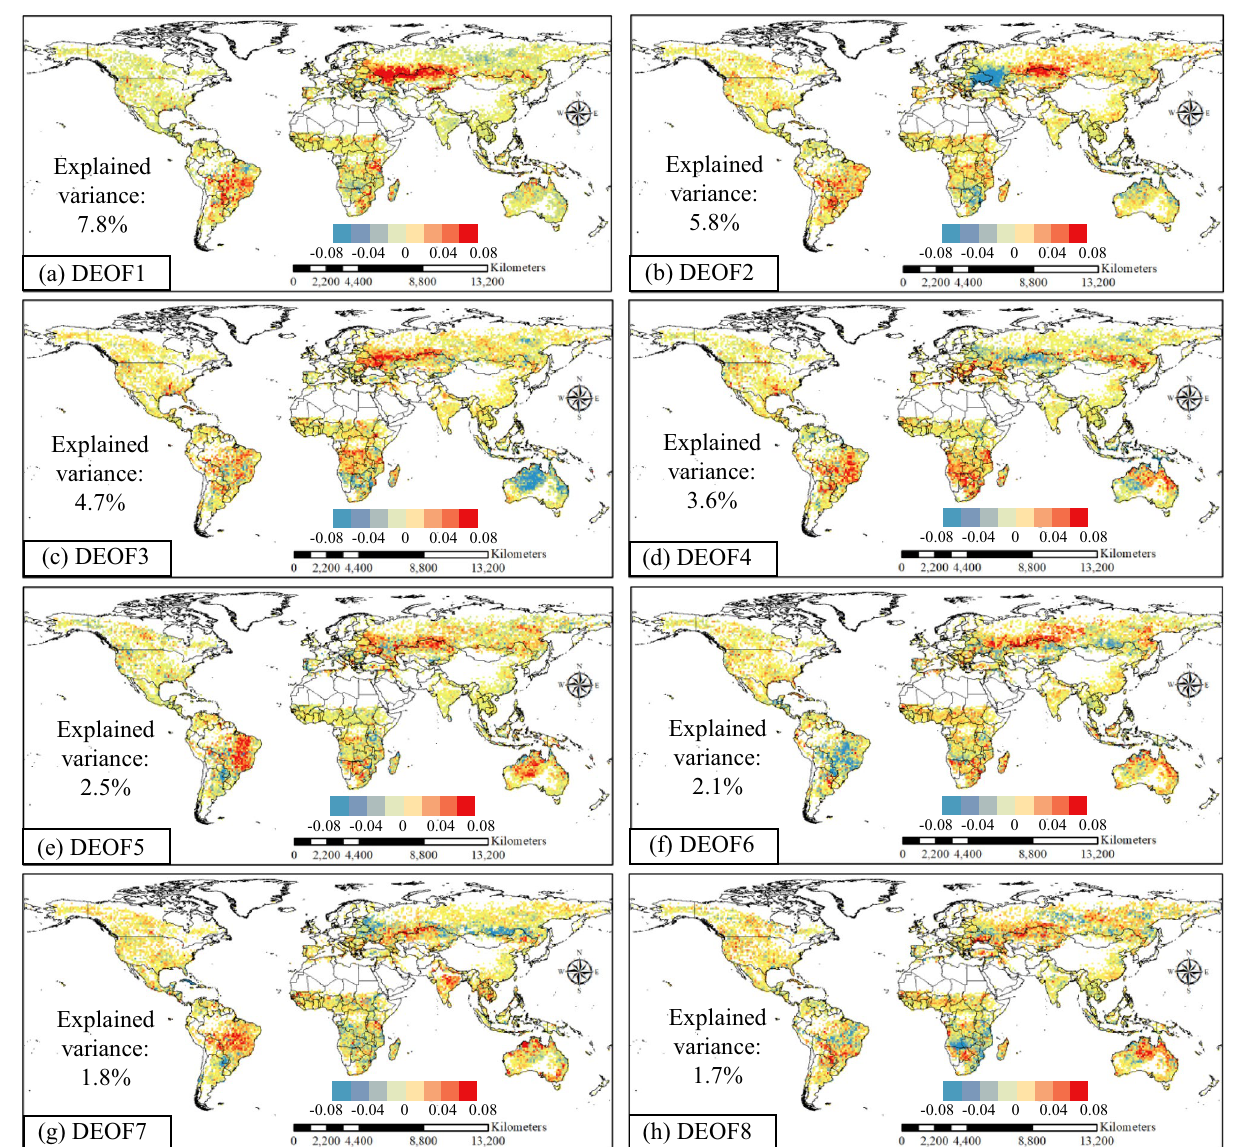
Figure 1. DEOF1–8 for the spatial distribution of log BAA. This figure was generated using ArcGIS version 10.1 (https:// www. esri. com/ en- us/ home). The data used in the calculation comes from Fire CCI v5.1 dataset (https:// geogra. uah. es/ fire_ cci/ firec ci51. php). Shape for countries of the world downloaded from Geografía, SIG y Cartografía Digital. (http:// tapiq uen- sig. jimdo free.